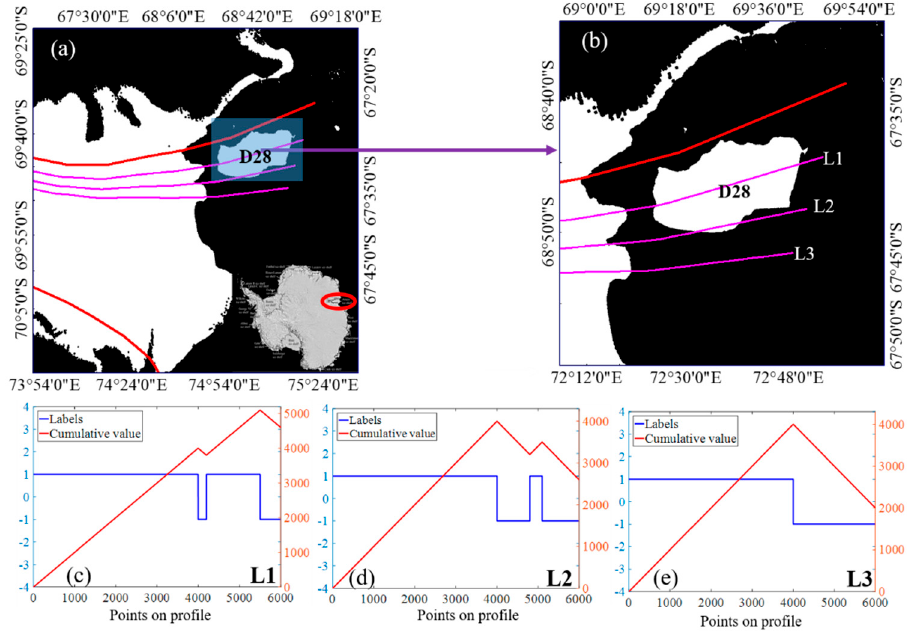
Figure 3. Frontal points extraction criterion for different ice conditions. In ( a , b ), the red line is the boundary we defined in this study and the magenta is the defined profile line. Figures ( c – e ) illustrate the cumulative values for three different situations for fontal points extraction. ( c ) it means profiles cross the main body of floating ice. ( d ) it means profiles cross a small part of floating ice. ( e ) it means no floating ice along the profile.